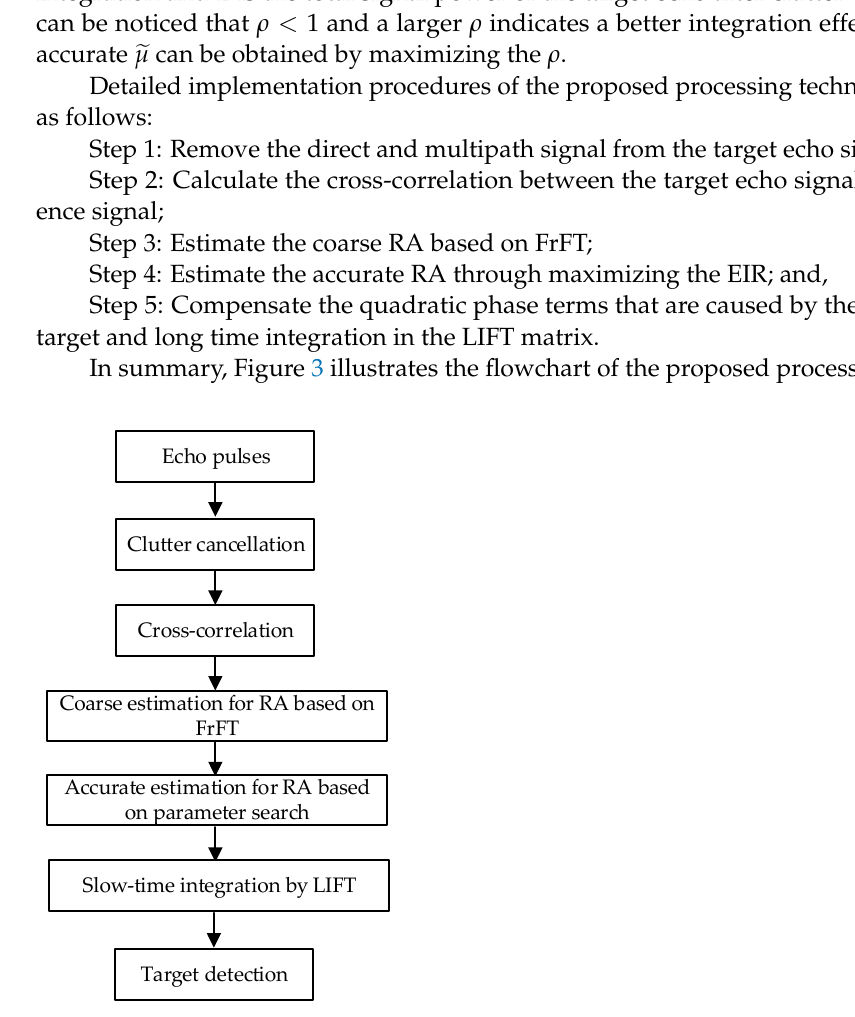
Figure 3. Flowchart of the new imaging approach.